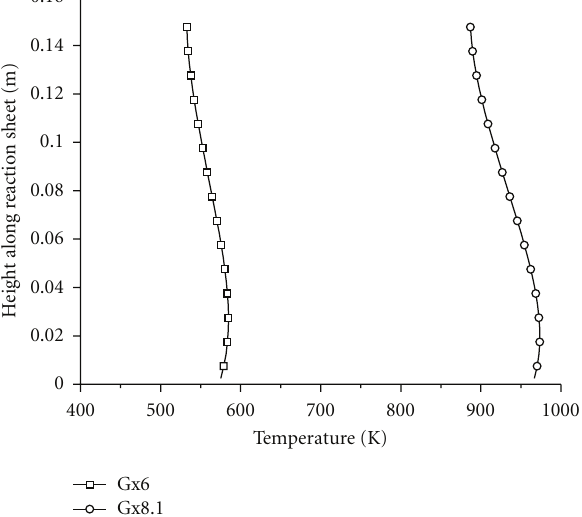
Figure 14: Catalyst surface temperatures along the catalytic sheet for Gx test series.